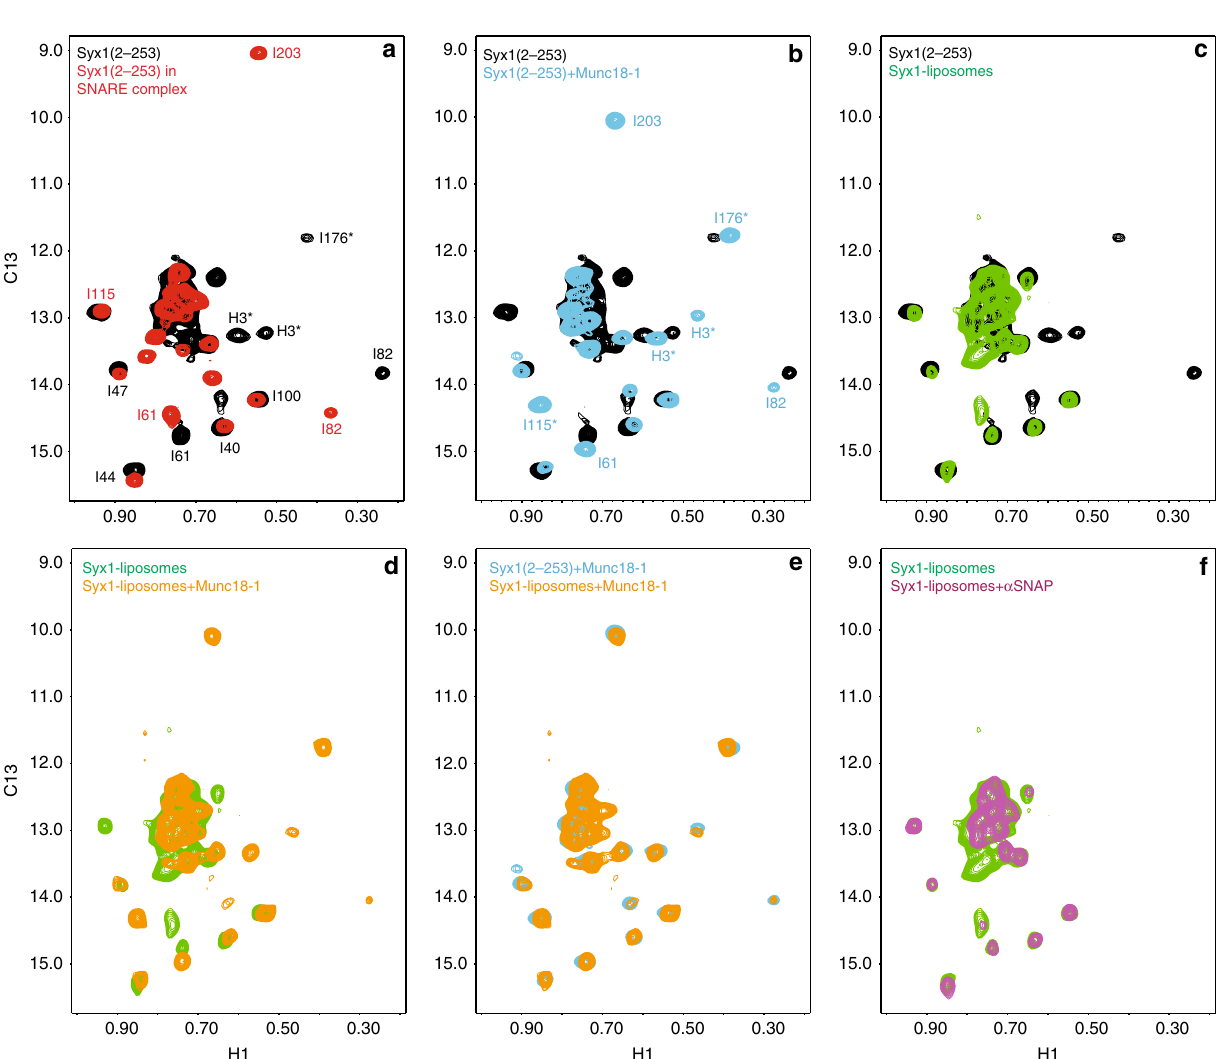
Fig. 8 Munc18-1 and α SNAP bind to different conformations of liposome-anchored syntaxin-1. The contour plots show superpositions of 1 H- 13 C HMQC spectra of: a 2 H-I- 13 CH 3 -syntaxin-1(2 – 253) alone (black contours) or incorporated into the SNARE complex with the SNARE motifs of synaptobrevin and SNAP-25 (red contours); b 2 H-I- 13 CH 3 -syntaxin-1(2 – 253) alone (black contours) or bound to Munc18-1 (blue contours); c 2 H-I- 13 CH 3 -syntaxin-1(2 – 253) (black contours) and liposomes containing 2 H-I- 13 CH 3 -syntaxin-1 (green contours); d liposomes containing 2 H-I- 13 CH 3 -syntaxin-1 alone (green contours) or bound to Munc18-1 (orange contours); e 2 H-I- 13 CH 3 -syntaxin-1(2 – 253) bound to Munc18-1 (blue contours) and liposomes containing 2 H-I- 13 CH 3 - syntaxin-1 bound to Munc18-1 (orange contours); and f liposomes containing 2 H-I- 13 CH 3 -syntaxin-1 alone (green contours) or bound to α SNAP (purple contours). In a , b , cross-peak assignments that are available 21,62,63 are indicated. Most of these assignments correspond to the H abc domain. In addition, three cross-peaks were tentatively assigned to I176, which is located in the linker between the H abc domain and the SNARE motif, and to isoleucines in the SNARE motif (labeled H3) 21 . The * indicates the tentative nature of these